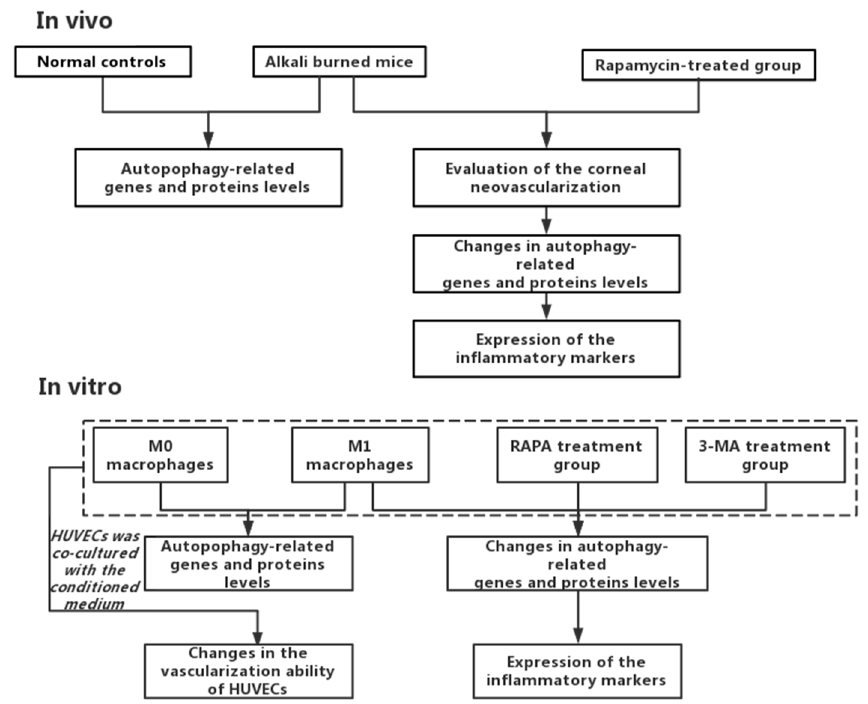
Figure 1. The general route diagram.